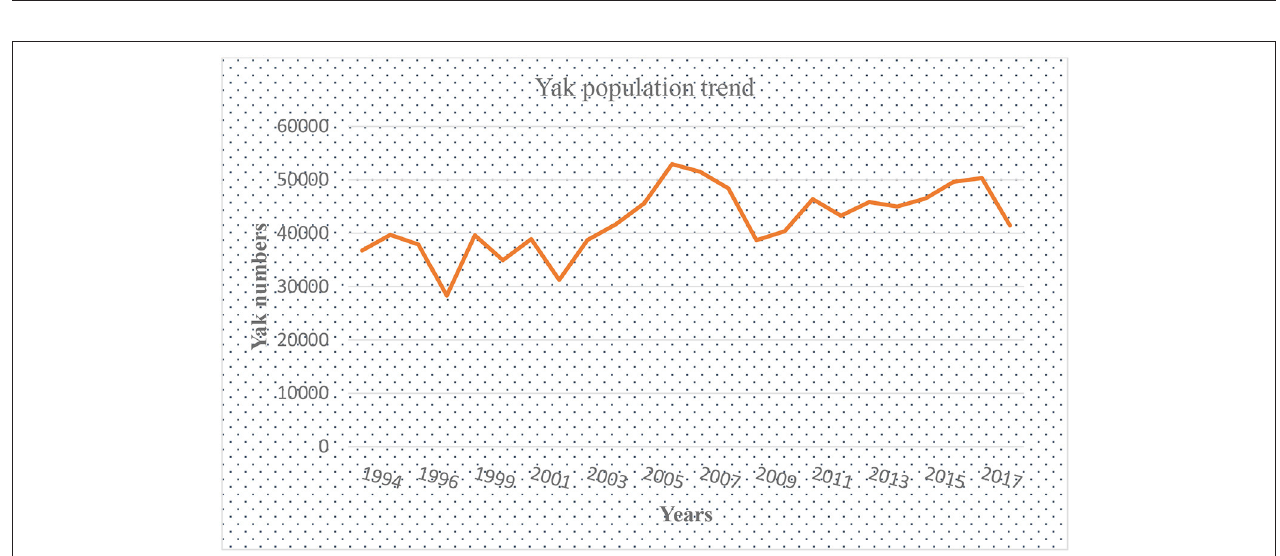
FIGURE 1 | Cattle population change.